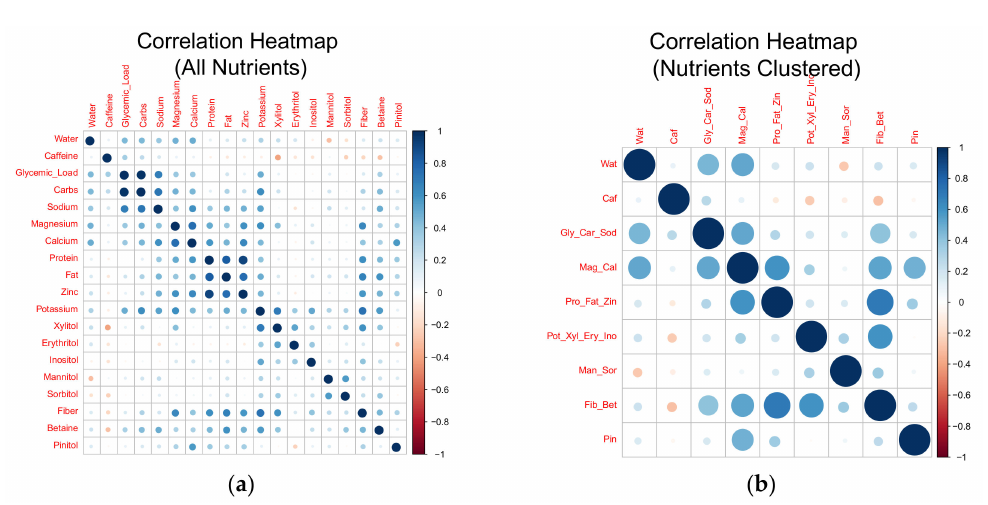
Figure 3. Correlation heat-map of 19 nutrients, hierarchically clustered ( a ) and consolidated through clustering and ensemble-averaged ( b ).